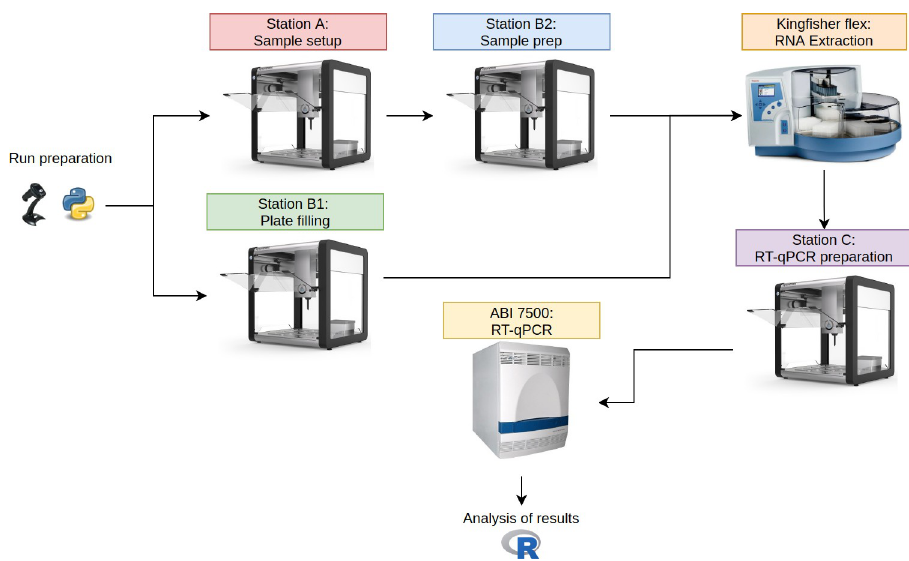
Fig 1. Diagram of the OT2-KF circuit. Note that station A and station B1 can be run simultaneously. The full configuration of labware for OT2 stations is available as S2 File.